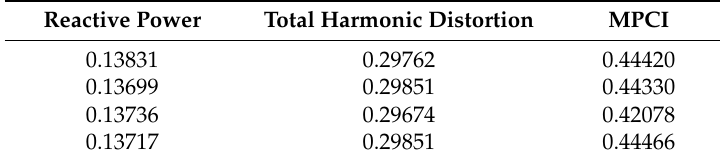
Table 6. MPCI values for the central point experimental runs collected from cloud data base.